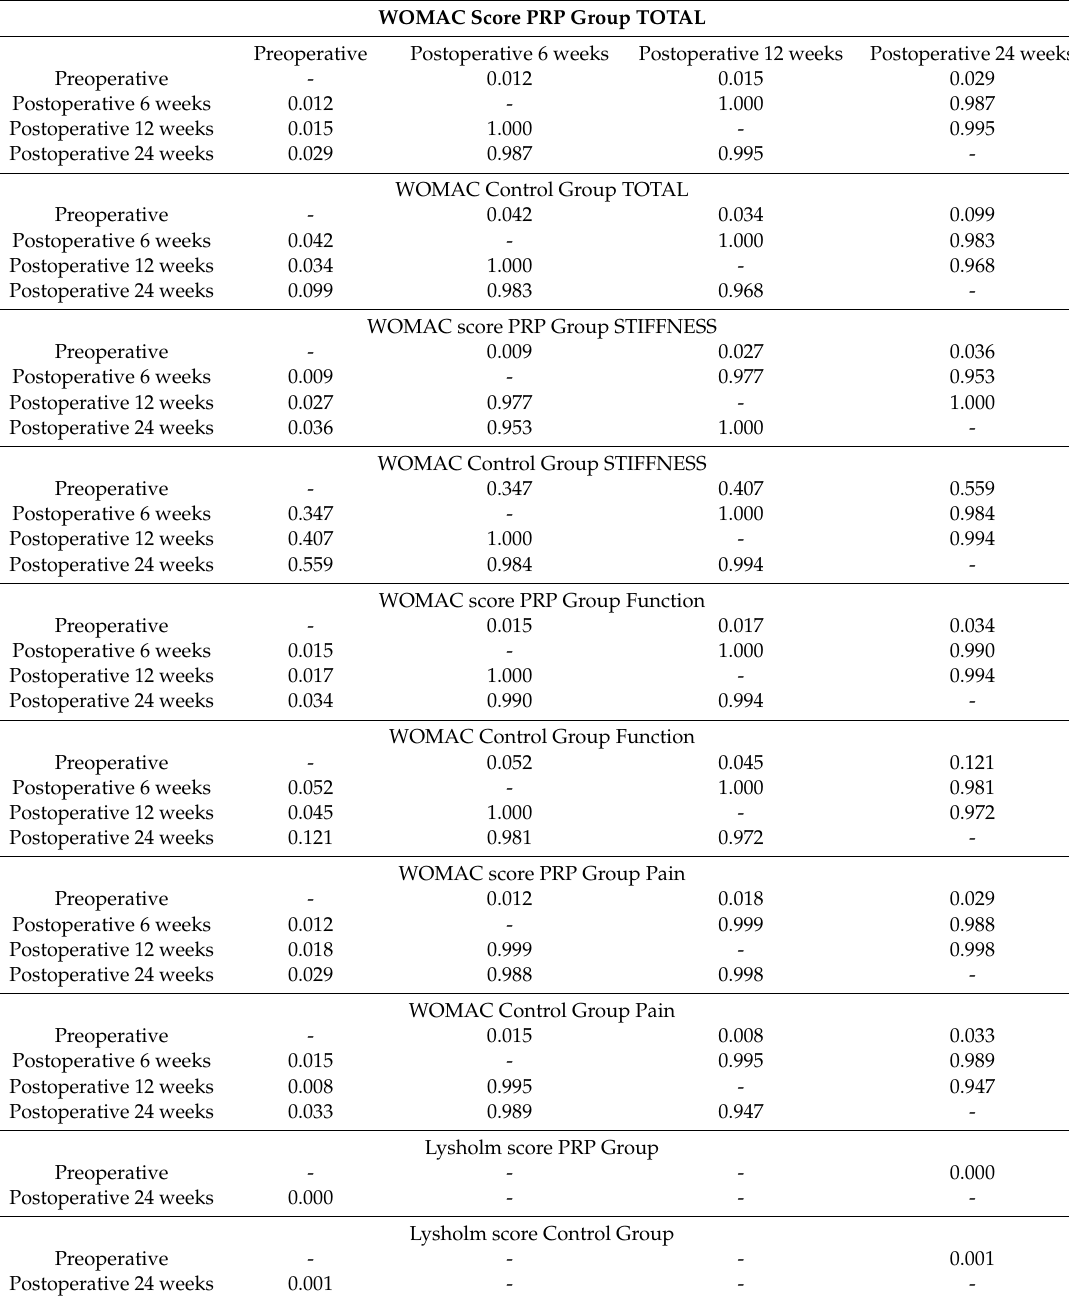
Table 3. Results from statistical analysis of WOMAC and Lysholm score for the PRP and control